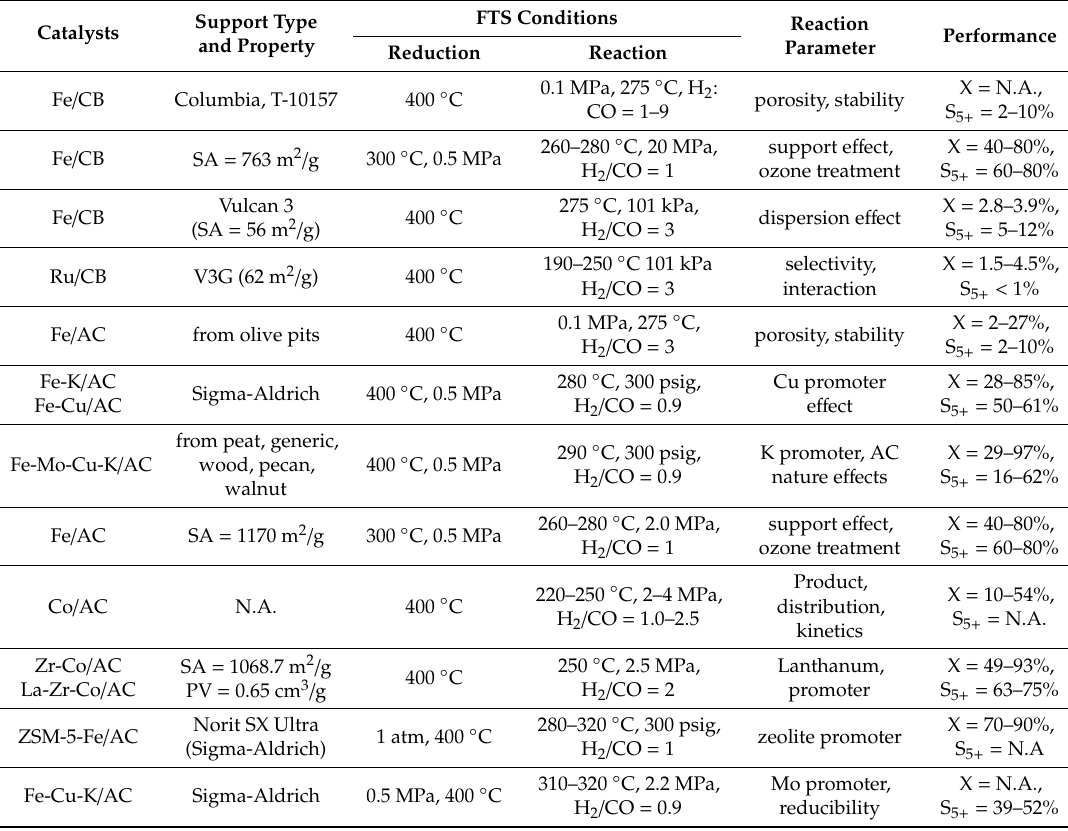
Table 3. Carbon properties, reaction conditions, and research theme of carbon black- and activated carbon-supported catalysts used in Fischer–Tropsch synthesis